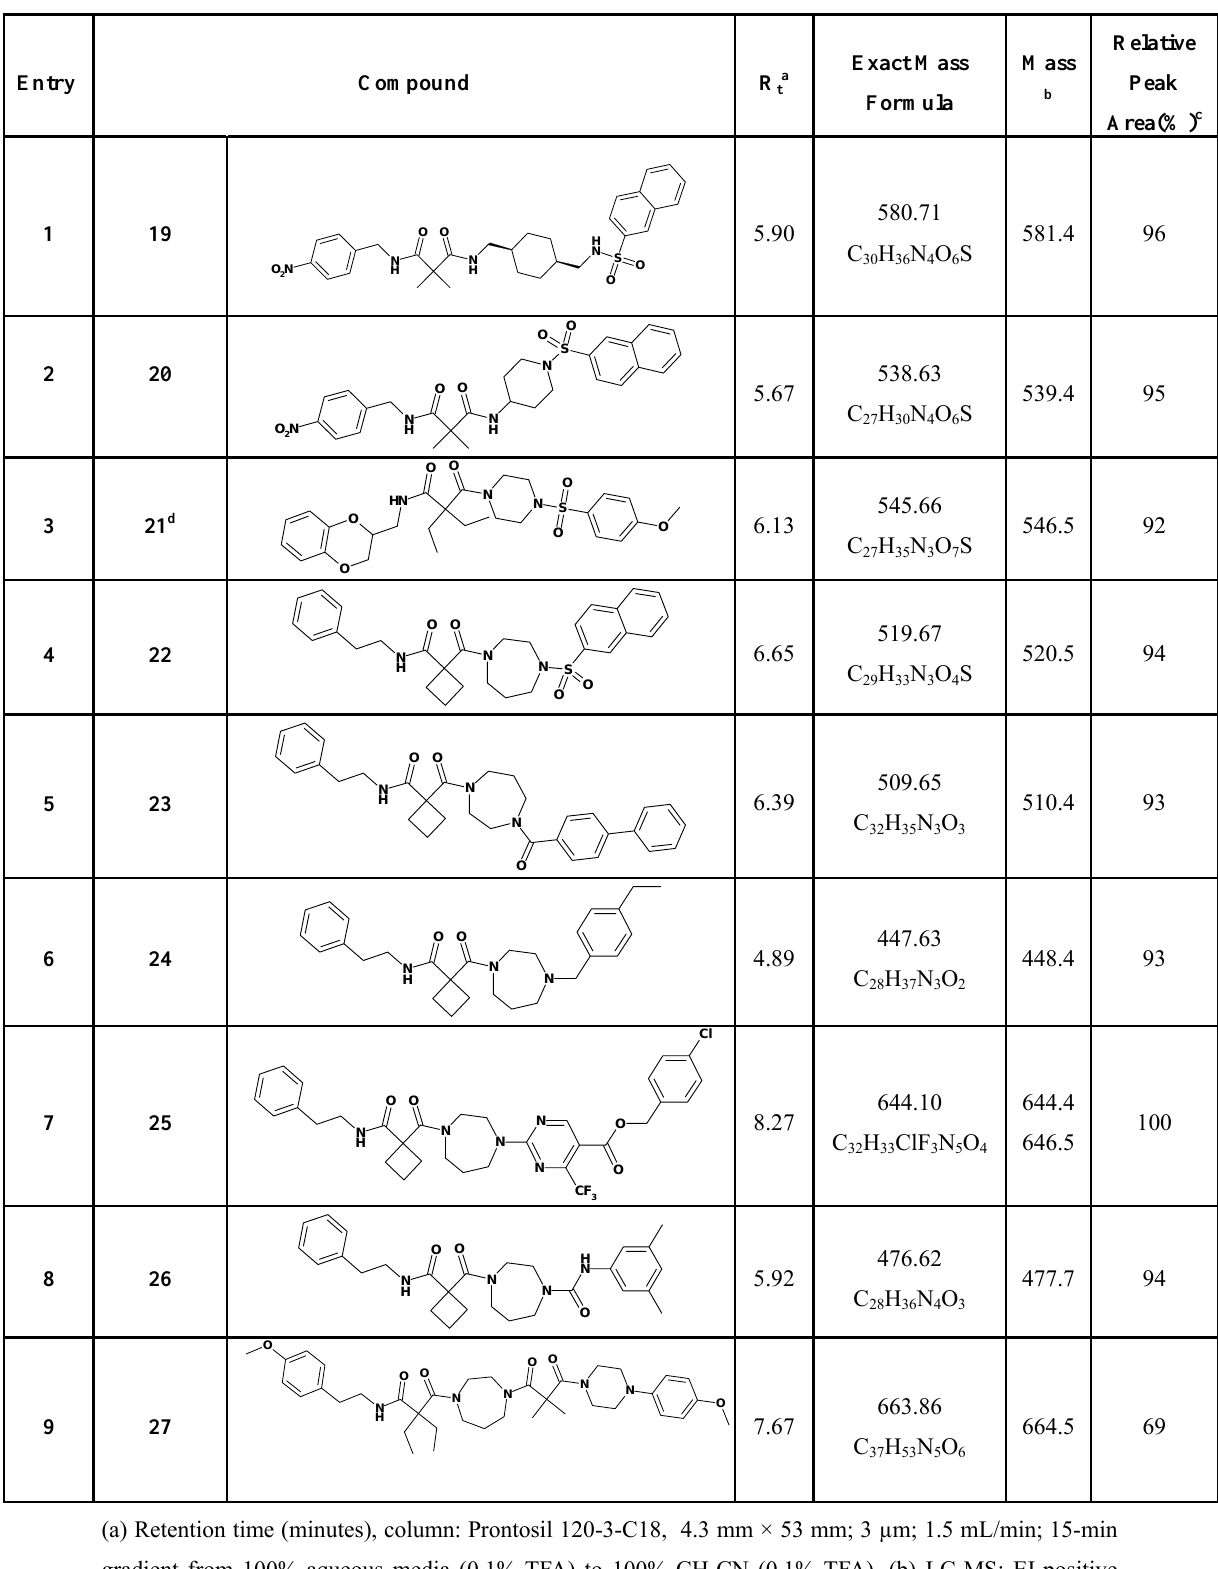
Table 2. Solid-phase synthesis of